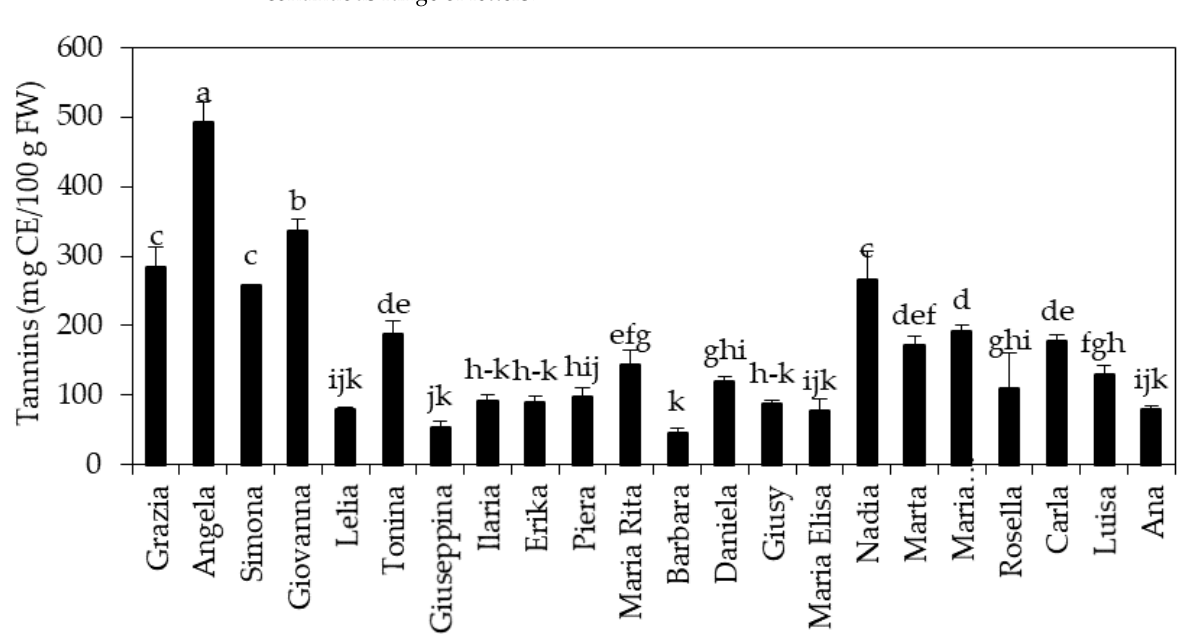
Figure 4. Tannins content in berries of 22 myrtle cultivars. The results are expressed as means and standard deviation of three biological replicates. Histograms labelled with different letters indicate values significantly different ( p < 0.05) according to the Tukey test. Hyphen separate a continuous range of letters.